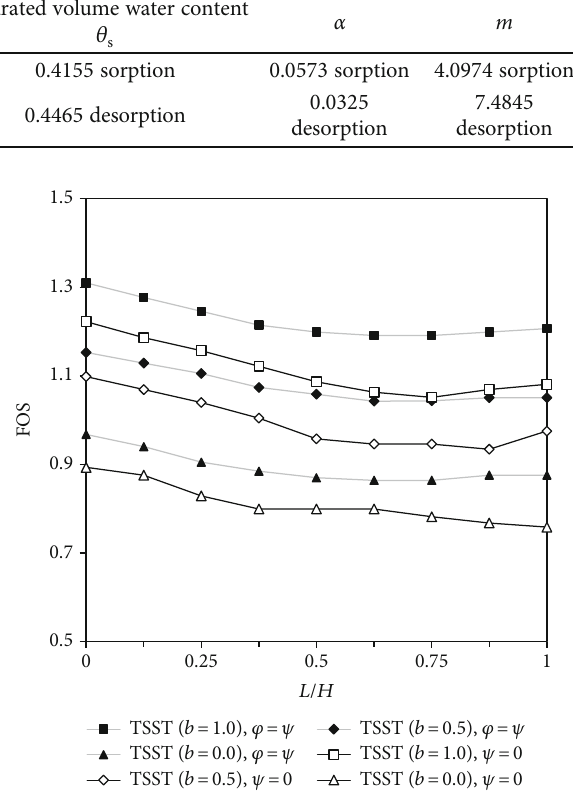
Figure 1: Relation between slope FOS and water level L / H during the falling of water